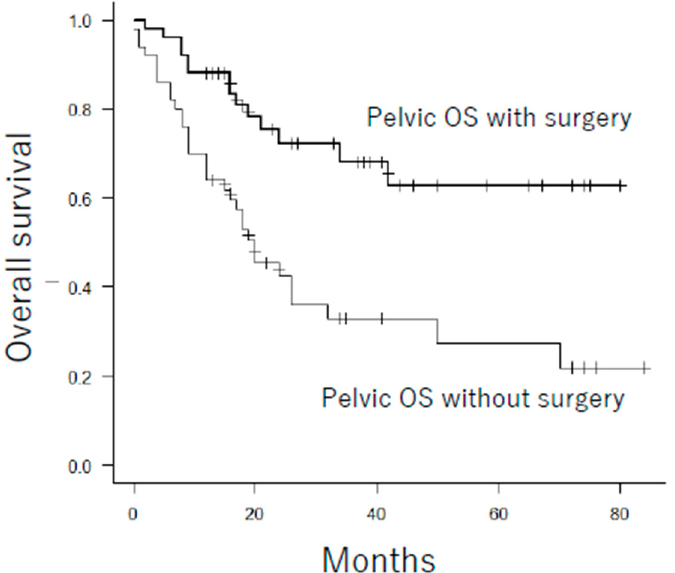
Figure 4. Overall survival for patients with pelvic osteosarcoma treated with and without surgical resection after propensity score matching ( p < 0.001). OS: osteosarcoma